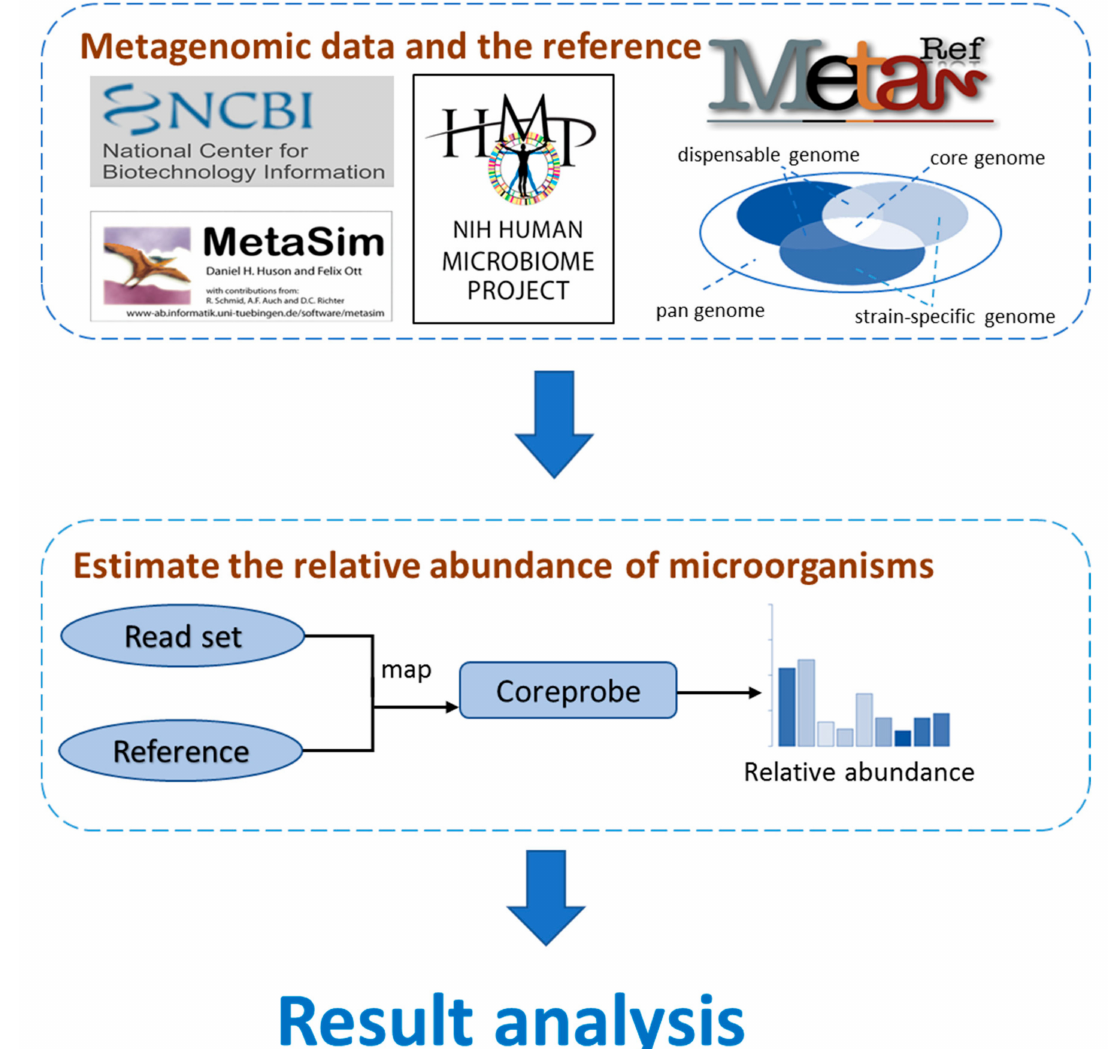
Figure 1. Overview of the overall content of the article. We first downloaded the reference sequence from the National Center for Biotechnology Information (NCBI) database (https://www.ncbi.nlm.nih.gov/), the MetaRef database, and simulated the metagenomic data with MetaSim software [48]. We then used our CoreProbe to analyze the simulated data to estimate the genome relative abundance, to compare them with the existing methods to assess the accuracy and efficiency of our method. Last, our method was applied to the actual data obtained from Human Microbiome Project (HMP), and a preliminary analysis was made to support the practicability of our